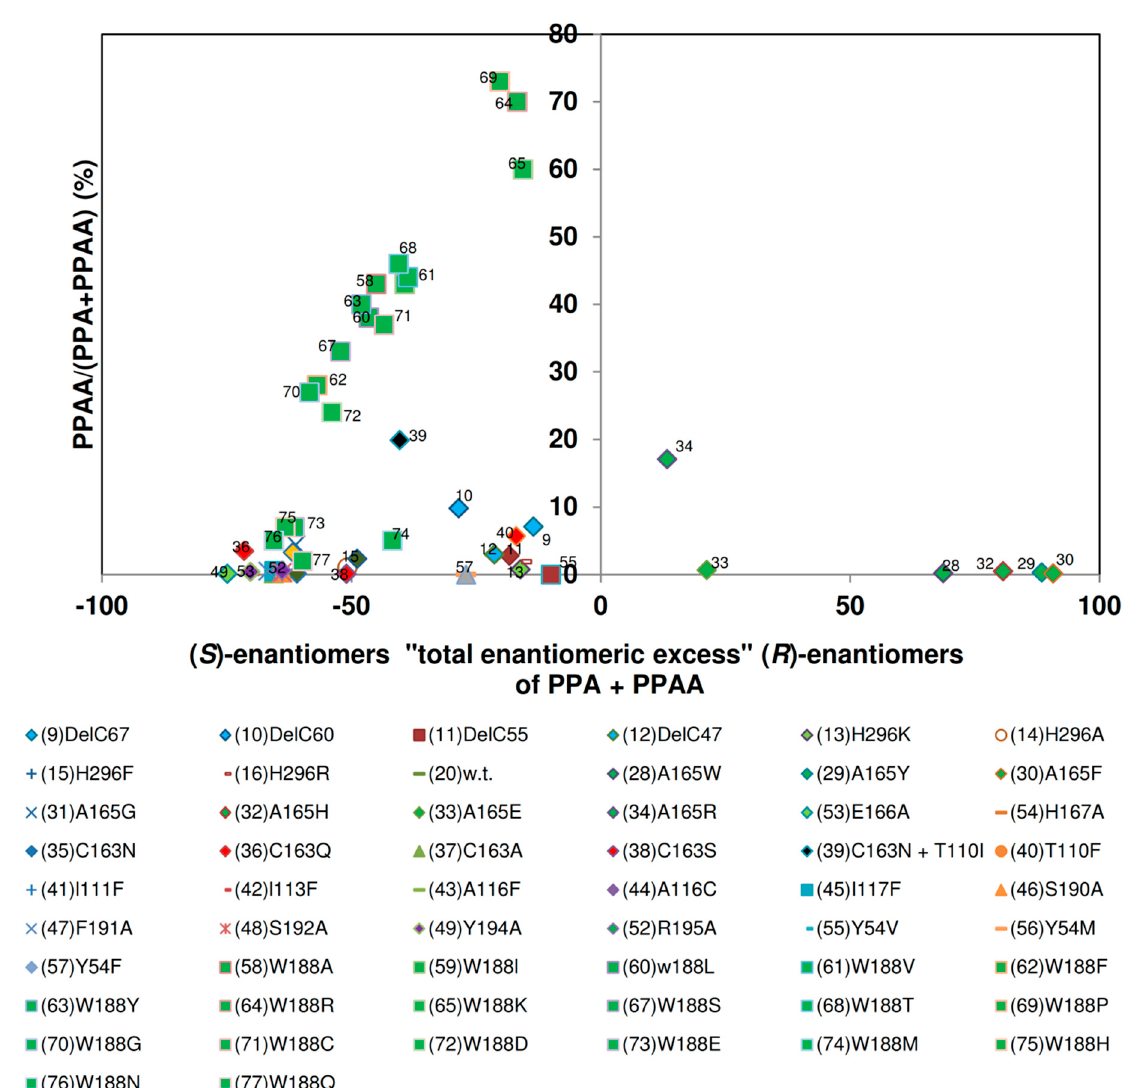
Figure 14. Correlation between the relative amounts of 2-phenylpropionamide formed and the “total enantiomeric excess” of the products formed during the conversion of ( R , S )-2-phenylpropionitrile. The data were taken from the previous publications (see Figure 6).